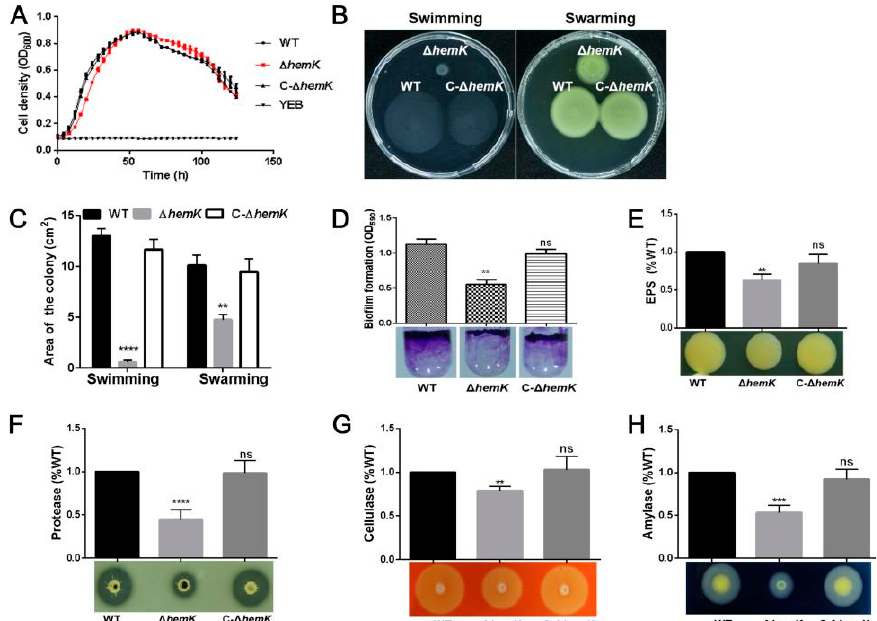
Figure 1. HemK influences the production of cell motility, biofilm formation, extracellular polysaccharides, and enzymes in Xcc jx-6. ( A ) The growth rates (OD 600 values) of the wild-type (WT) strain Xcc jx-6, Δ hemK, and C- ∆ hemK on YEB at 28 °C were measured at 4 h intervals. ( B ) Swimming and swarming motility for the WT strain, Δ hemK, and C- ∆ hemK were detected on a 0.28% agar swimming plate and 0.6% agar swarming plate, respectively. A 2 µL aliquot of the bacterial suspension was inoculated onto the swimming plate or swarming plate and incubated for 60 h at 28 °C to observe the bacterial motility. ( C ) The level of motility was determined by measuring the area of the colony with ImageJ. ( D ) The biofilm formation of the WT strain, ∆ hemK, and C- ∆ hemK in glass tubes was detected by crystal violet staining and quantified by measuring the optical density at 590 nm, after dissolution in 33% acetic acid. ( E ) The production of extracellular polysaccharides (EPS) of the WT strain, ∆ hemK, and C- ∆ hemK was assessed on 2% glucose NYGA, and the production was measured with ethanol precipitation. ( F – H ) A 20 µL (for proteases) or 2 µL (for cellulases and amylases) aliquot of bacterial supernatant was added to the exoenzymes’ test plates and incubated at 28 °C for 48 h. The production of hydrolysis circles by cellulases, amylases, and proteases was measured on plates containing 1% ( m / v ) skimmed milk ( F ), 1% ( m / v ) sodium carboxymethyl ethyl cellulose ( G ), and 1% ( m / v ) potato starch ( H ), respectively. All experiments were repeated three times, with three repetitions for each strain. Only one representative result is presented. A significant difference between the WT and ∆ hemK was demonstrated with the respective treatments: **** p < 0.0001, *** p < 0.001, ** p < 0.01, ns: no significance (Student’s t -test).